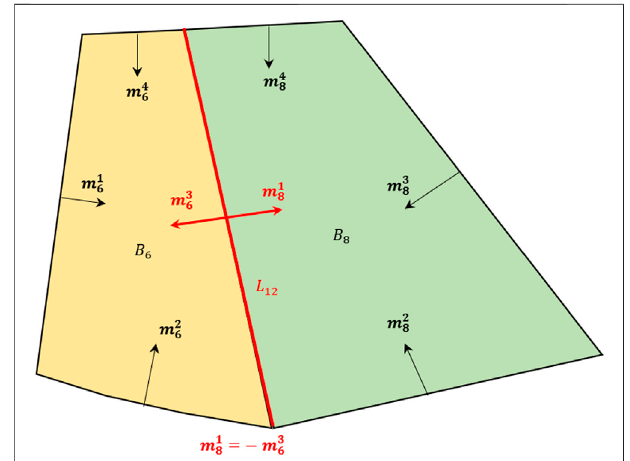
FIGURE 2 | De fi nition of the normal vector in the interface